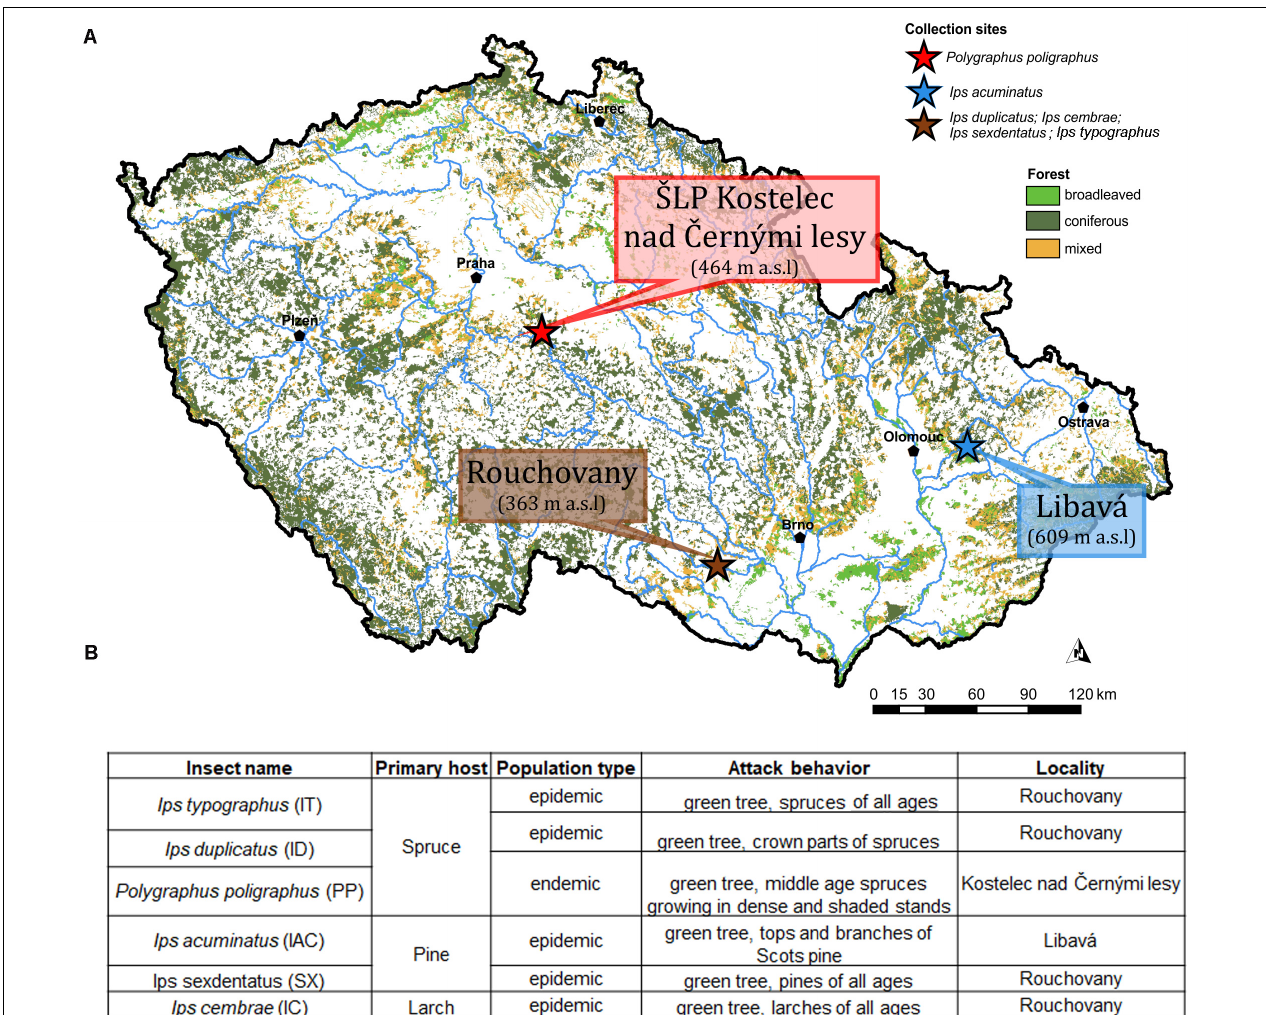
FIGURE 1 | (A) Sampling site. The different sampling location for bark beetle collection. Ips duplicatus (ID), Ips typographus (IT), Ips sexdentatus (SX), and Ips cembrae (IC) are collected from Rochovany, Czech Republic. Polygraphus poligraphus (PP) is collected from Kostelec nad ˇCernými lesy, and Ips acuminatus (IAC) is collected from Libavá, Czech Republic. (B) Ecology, population phase and attack behavior of the collected beetles (Lieutier et al.,